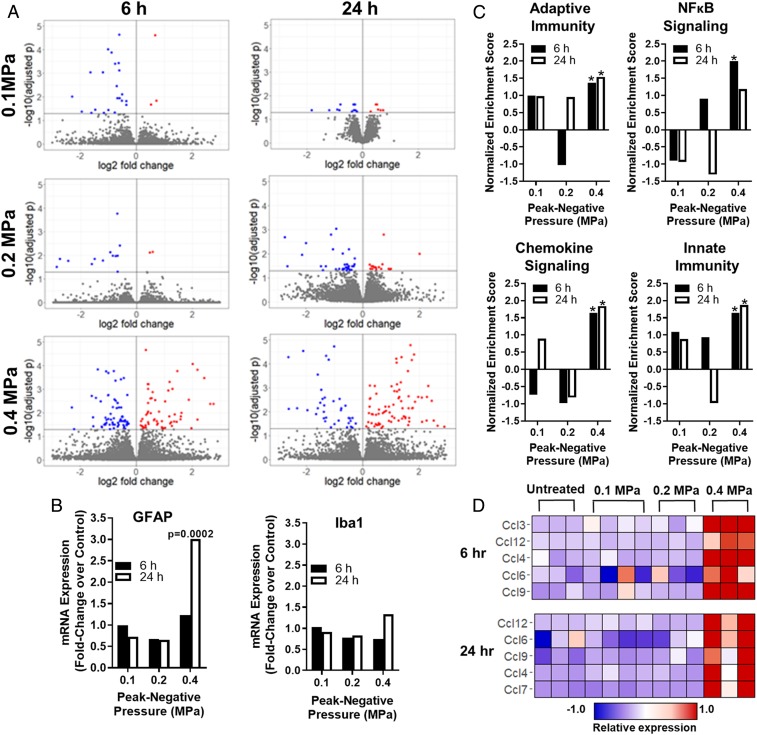
Sonoselective transfection of cerebrovascular endothelium at low PNP is achieved without eliciting a sterile inflammation response. (A) Volcano plots of differentially regulated transcripts at 6 and 24 h after pulsed FUS application to the brain (0.1 MPa [blue], 0.2 MPa [green], and 0.4 MPa [red]) in the presence of systemically administered MBs. Note the increase in differentially regulated transcripts with increasing NPN. (B) Bar graphs of transcripts used to assess astrogliosis (GFAP) and microgliosis (Iba1). Expression is shown as a fold change over normal brain tissue. No changes were observed in Iba1 expression, while GFAP expression was only increased at 24 h in response to 0.4-MPa FUS. (C) Gene-set enrichment analyses for selected pathways associated with inflammation and immunity. All pathways were significantly enriched at 0.4 MPa; however, none was enriched at 0.1 MPa or 0.2 MPa. *P < 0.05 vs. untreated brain tissue. (D) Expression levels of selected chemokines identified via leading-edge analysis of the “Chemokine Signaling” pathway. Each column corresponds to a single mouse.